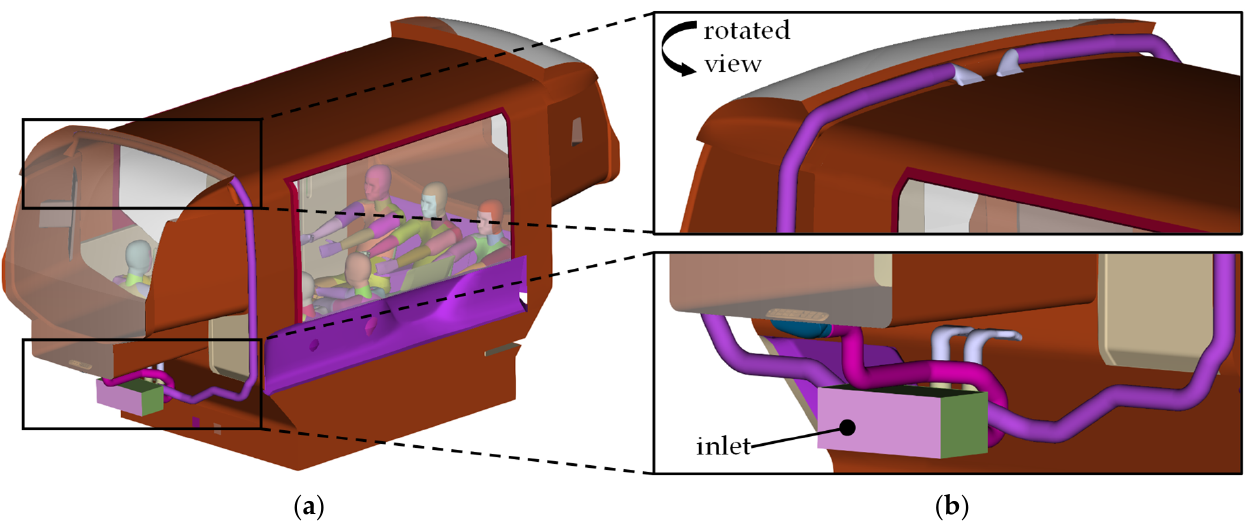
Figure 6. AutoSHUTTLE cabin simulation model: ( a ) isometric view of the model with six manikins with colored segments; ( b ) HVAC box with inlet and ducting.